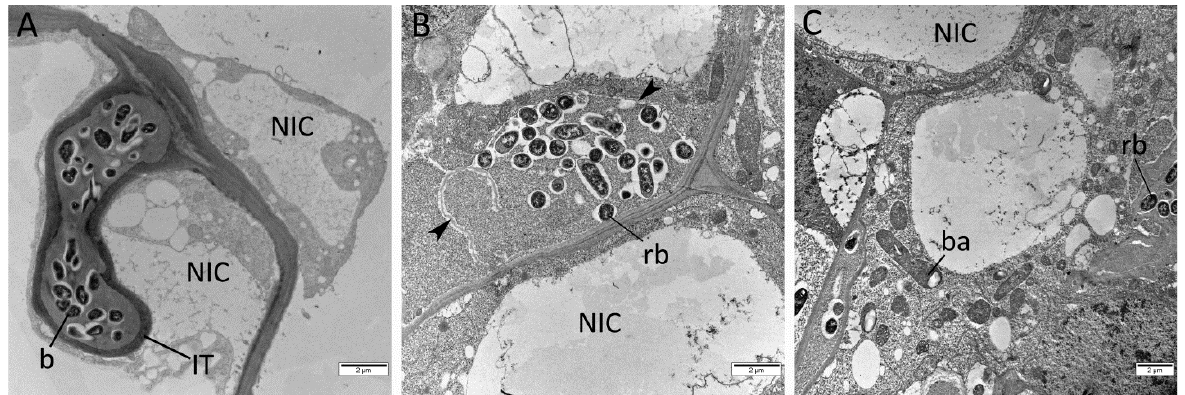
Figure 4. Transmission electron microscopy of nodules of sym33-3 mutant plants non-treated ( A ) or treated with 10 μM cytokinin 6 -BAP ( B , C ). There are noticeable differences between nodule cells in non-treated and treated mutant plants, where bacterial release from infection threads took place ( B , C ). Image A shows an infection thread (IT) with bacteria (b) inside it, surrounded by non-infected cells (NIC). Arrowheads indicate fragmented walls of the infection thread. Images B and C show infected cells with released bacterium (rb) and bacteroides (ba). The figure also shows neighboring non-infected cells (NIC). All figures shown are on a scale of 2 µm.